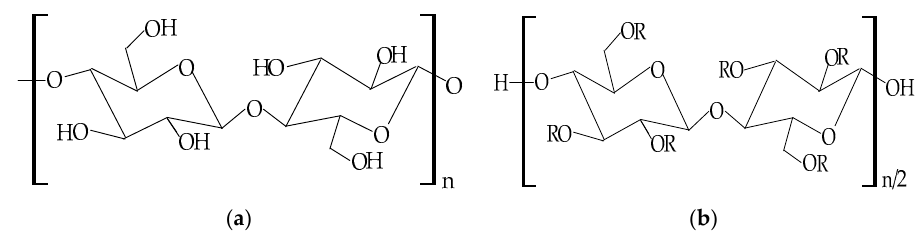
Figure 5. Chemical structures of: ( a ) cellulose; ( b ) cellulose derivatives. Cellulose ethers derivatives are characterized by high molecular weight and the greatest applicability in the pharmaceutical domain of all these derivatives are: sodium carboxymethylcellulose (NaCMC), hydroxypropylmethylcellulose (HPMC), methylcellulose (MC), hydroxyethylcellulose (HEC), ethylcellulose (EC), hydroxypropylcellulose (HPC), hydroxyethylmethylcellulose (HEMC) and benzylcellulose (BC) [126,127]. The cellulose ethers are illustrated in Table 1. Table 1. Main cellulose ether derivatives according to R groups [128] .